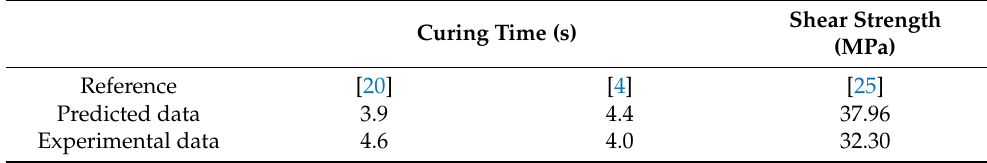
Table 3. Predicted and verified data of curing time and shear